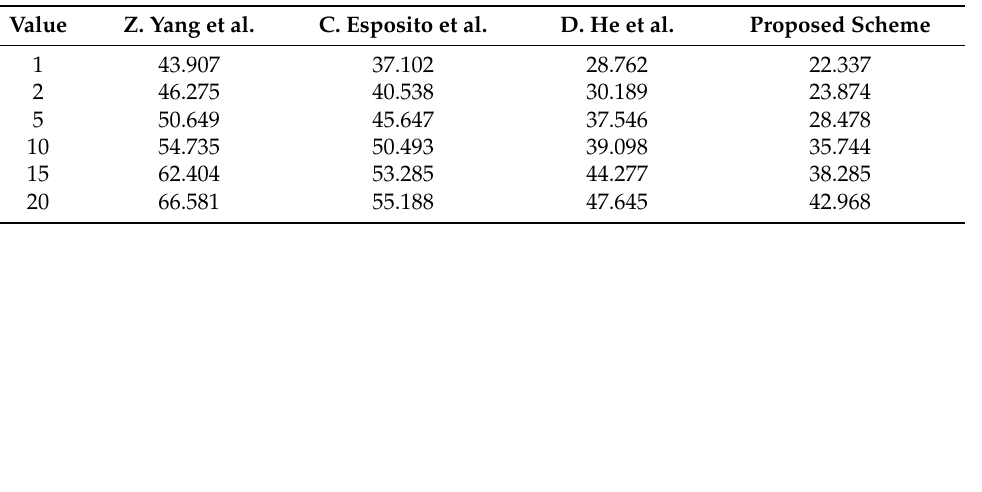
Table 5. Delay time for verification of the integrity of blockchain information. Units: